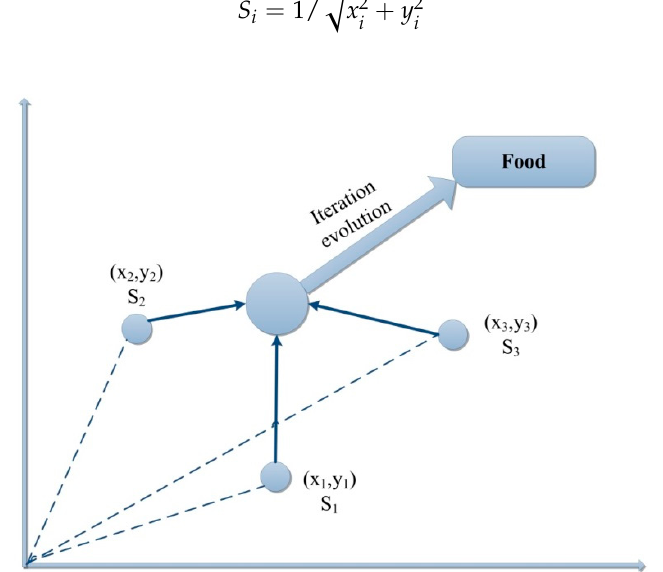
Figure 3. Food searching process utilized by the fruit fly iteratively.